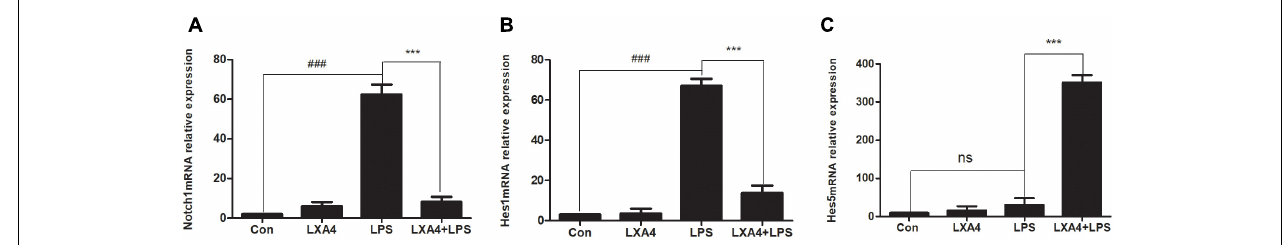
FIGURE 9 | Quantitative RT-PCR analysis of Notch1, Hes1 and Hes5 mRNA levels in the BV2 microglia. (A) Quantitative RT-PCR analysis of Notch1 mRNA levels. (B) Quantitative RT-PCR analysis of Hes1 mRNA levels. (C) Quantitative RT-PCR analysis of Hes5 mRNA levels.LPS upregluated M1 microglia related signal molecule Notch1, Hes1. With LXA4 intervention, Notch1, Hes1 expression decreased, M2 microglia related signal molecule Hes5 expression increased significantly. ### , ∗∗∗ p < 0.001; n.s., no significance.